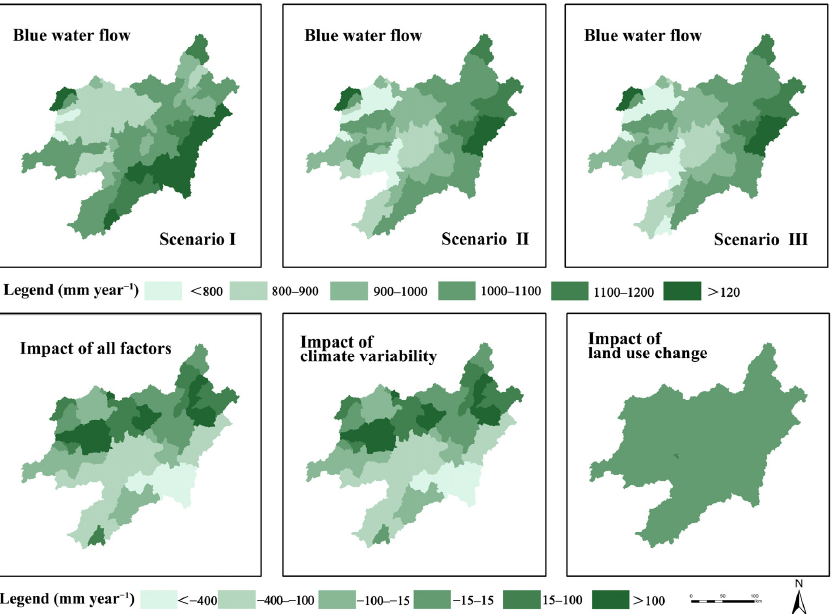
Figure 5. Spatial distribution of BWF and changes in BWF in the upper Ganjiang River basin under the individual or combined influence of climate and land-use change.